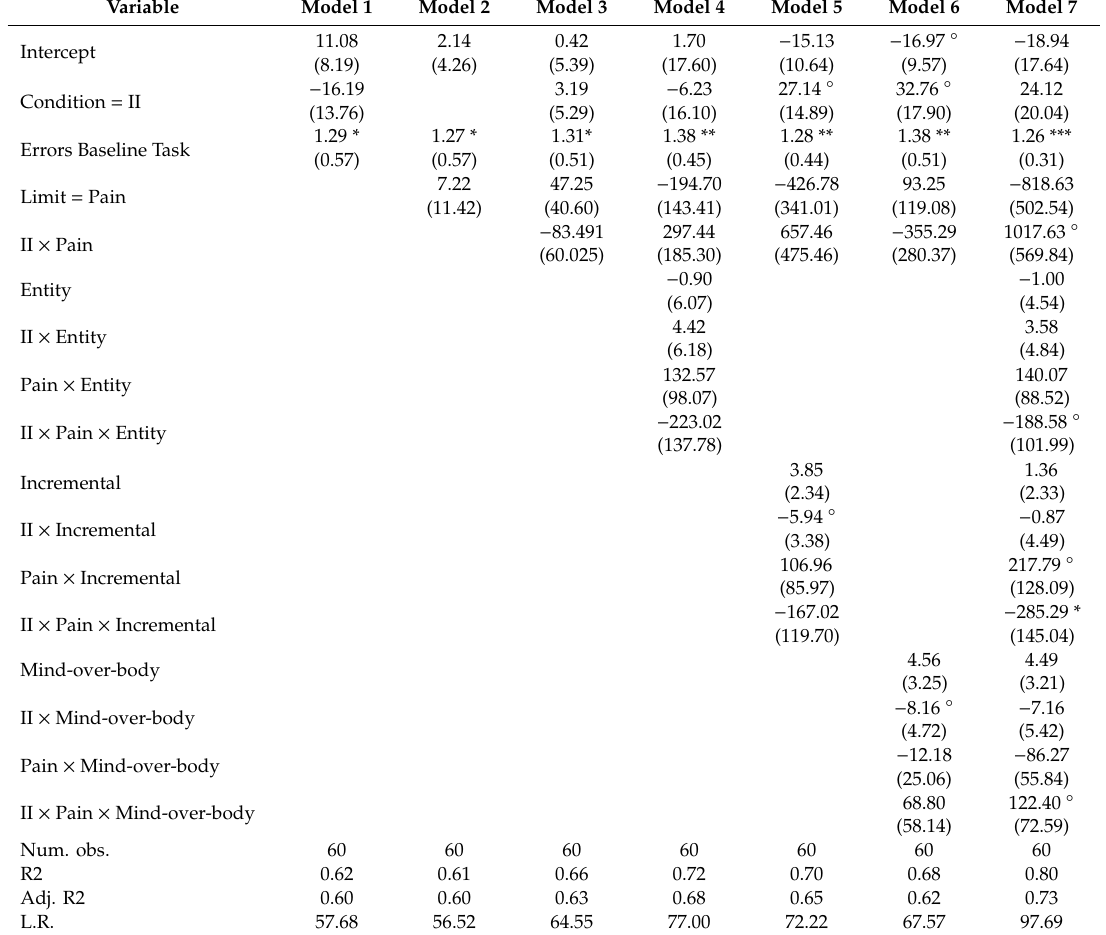
Table A1. Linear regression model for explaining errors in the main task in the HRT. The intercept represents the expected mean value of errors in the main task when all other predictors are equal to 0. Numbers in parentheses are robust standard errors. Baseline: Condition = Goal Intention, Limit (reason for baseline task termination) =